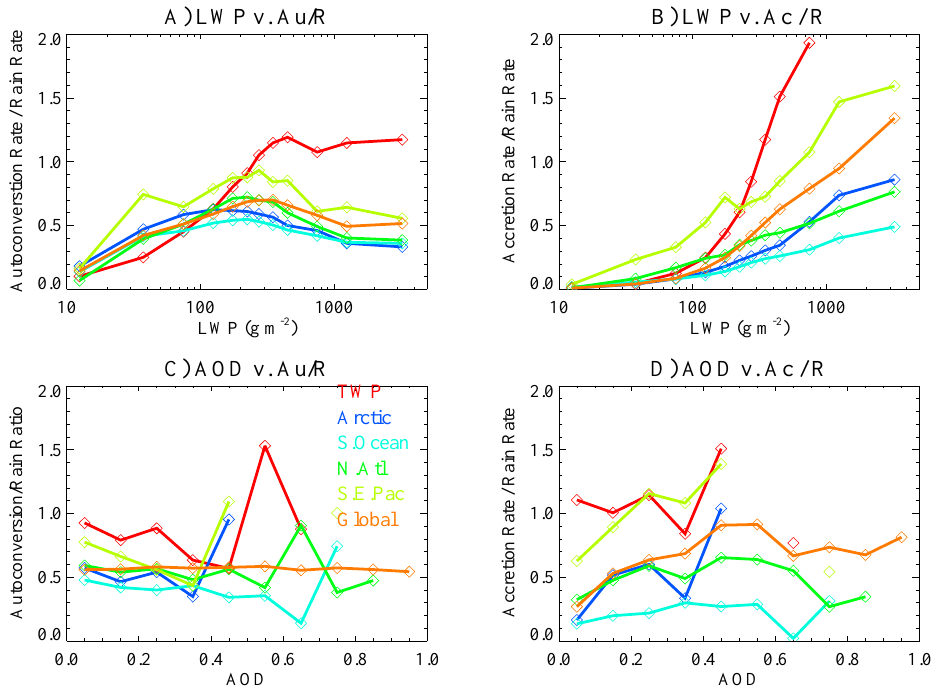
Figure 6. Regional averages of the ratio of vertically averaged (A, C) autoconversion and (B, D) accretion to surface precipitation rate for different regions (colors, see Fig. 5 for description) binned by (A, B) LWP and (C, D)